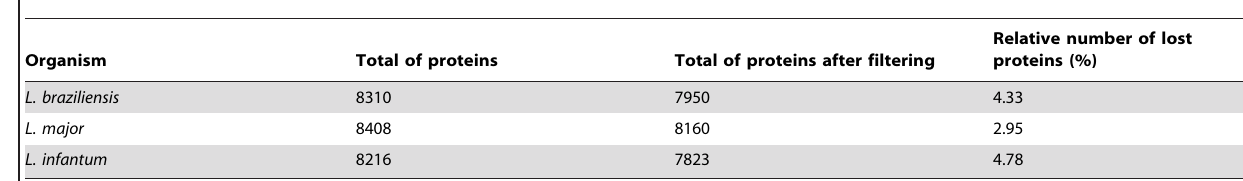
Table 2. Number of proteins in the predicted proteome of the target organisms before and after the filtering.